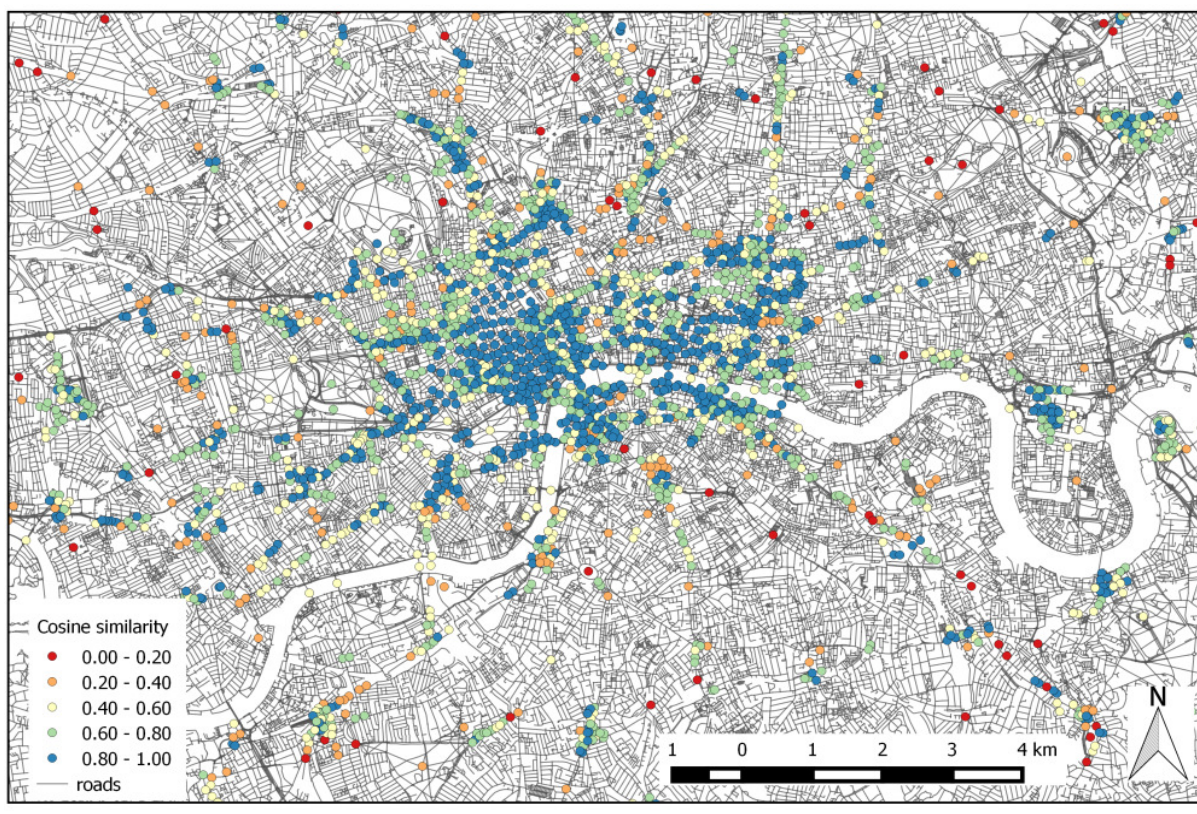
Figure 5: Cosine similarity with nearest neighbours